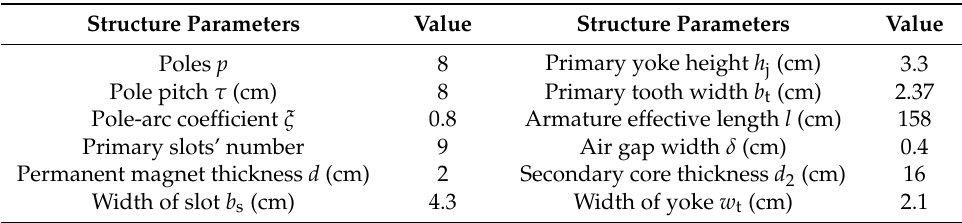
Table 1. Main structure parameters of the generator.